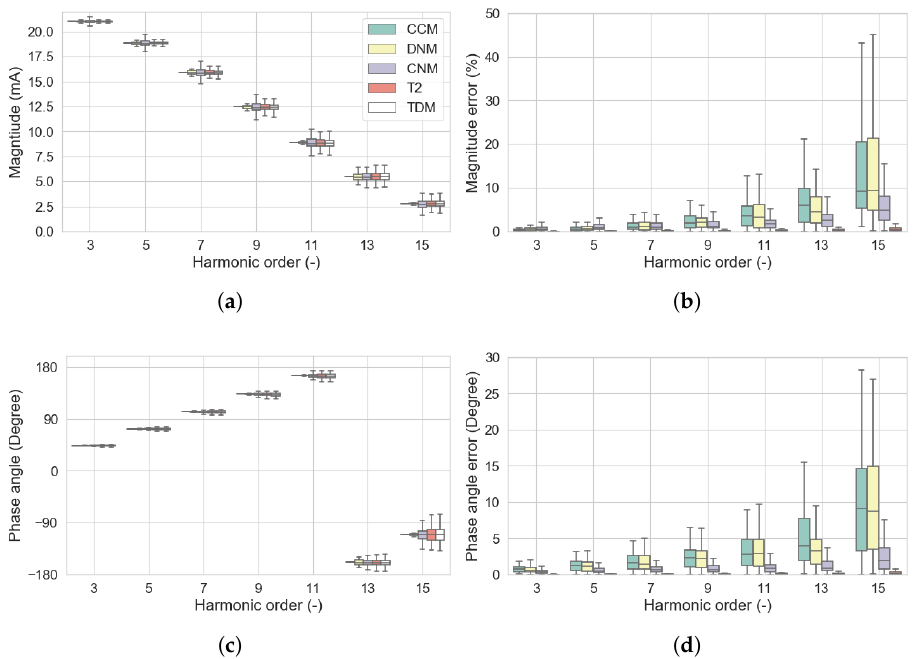
Figure 10. Comparison of the Type A LED lamp frequency domain models for peak-top voltage supply: ( a ) Magnitude; ( b ) Magnitude error; ( c ) Phase angle; and ( d ) Phase angle